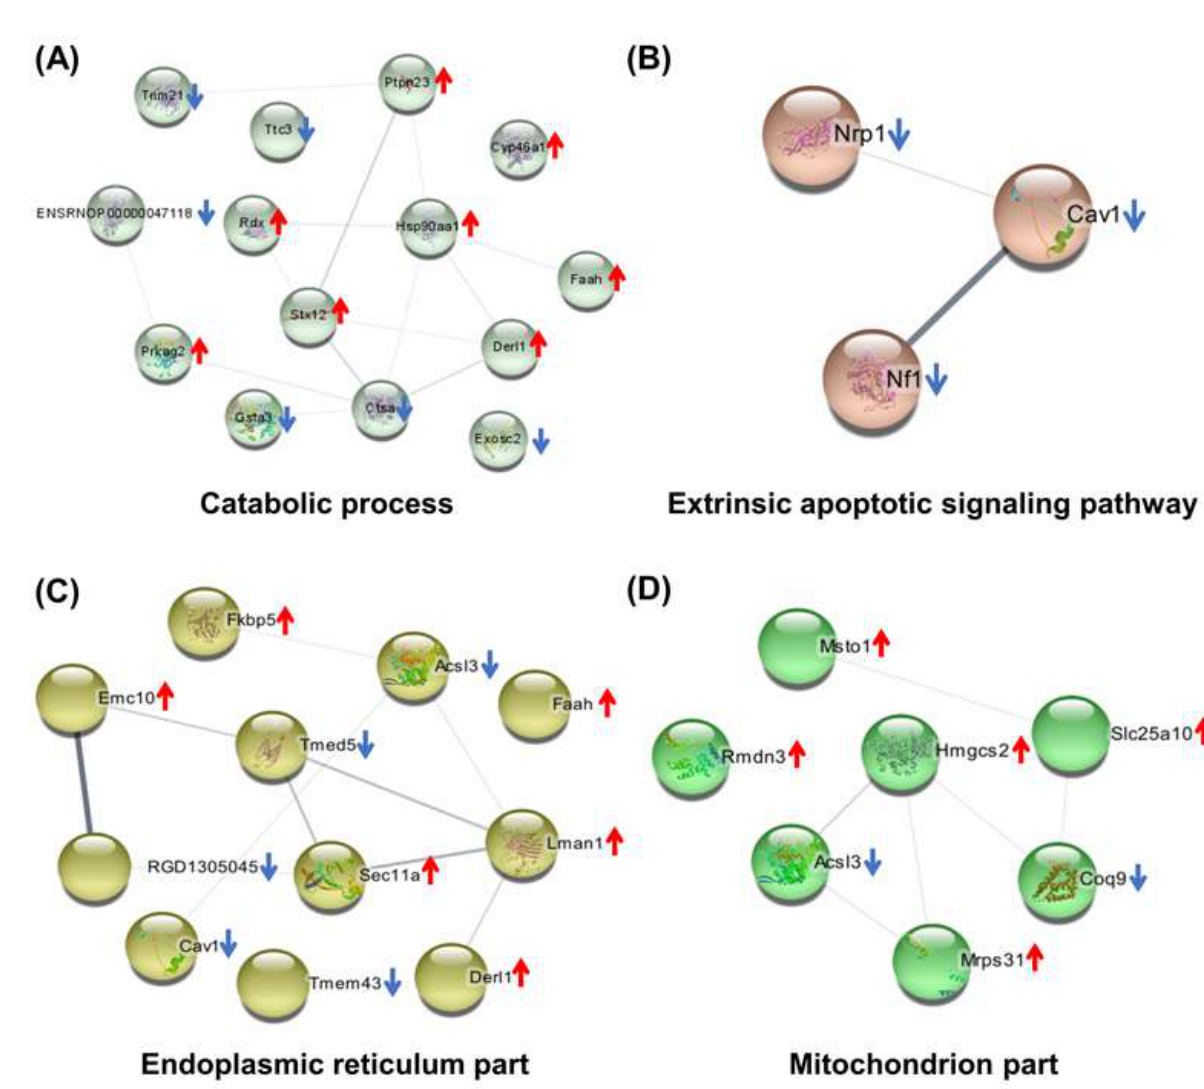
Figure 6. Bioinformatics analysis of the differentially expressed proteins in the As + DIP/As group. ( A – D ) PPI of DEPs involved in the catabolic process, extrinsic apoptotic signaling pathway, and endoplasmic reticulum and mitochondrion parts, respectively. ↑ , upregulated; ↓ , downregulated.